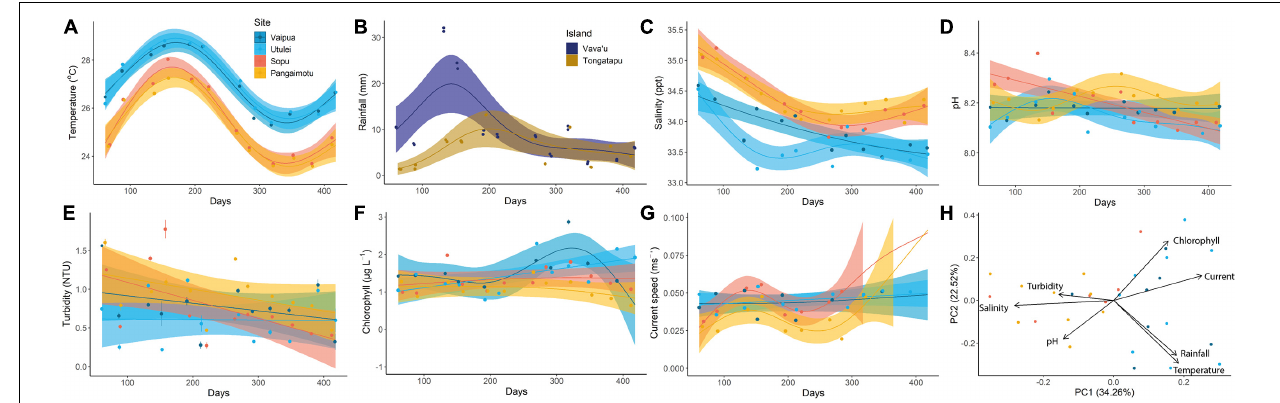
FIGURE 3 | Temporal variation in environmental conditions between culture sites (mean ± SE): (A) temperature; (B) daily rainfall; (C) salinity; (D) pH; (E) turbidity; (F) chlorophyll; (G) current speed; and (H) principle component analysis (PCA) biplot of environmental data showing vector loadings. Splines represent GAM model predictions ± 95% confidence intervals. Where one spline falls within the error envelope of another, there is no significant difference in mean measurements between those splines for that time period. Missing data was due to instrument